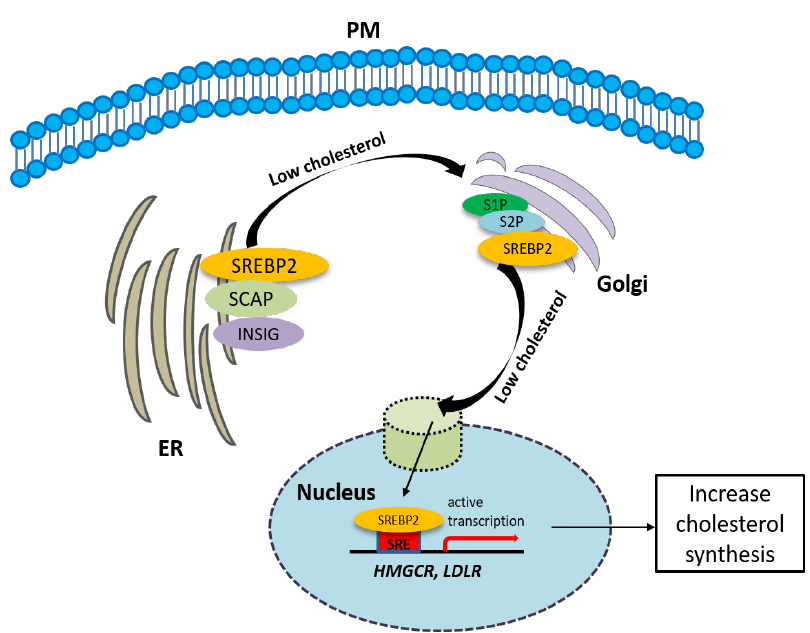
Figure 2. The synthesis of cholesterol is regulated by feedback control involving sterol regulatory element-binding protein 2 (SREBP2). See the text for the detailed information.